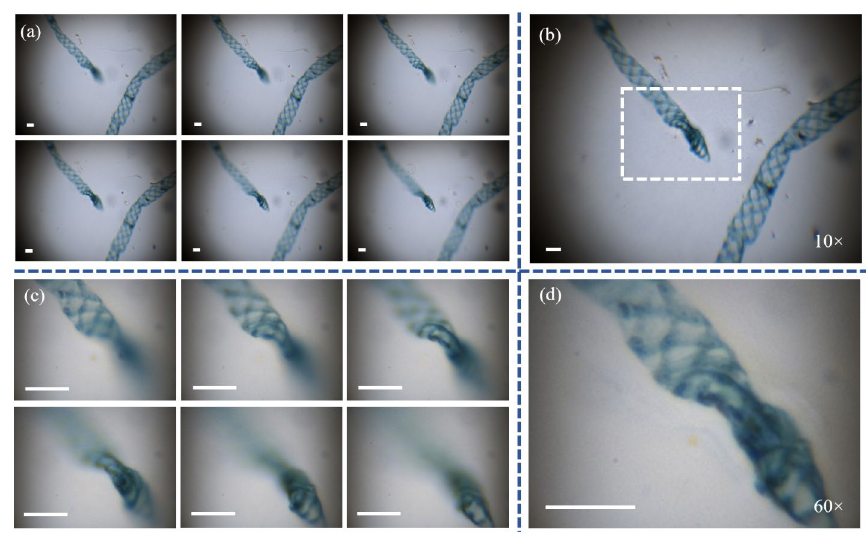
Fig. 10 Extended depth of field images of the sample “spirogyra communis”. (a) Image sequences of the “spirogyra communis” from the bottom to the top at the magnification of 10 × . (b)Result of the “spirogyra communis” image fusion at the magnification of 10 × . (c) Image sequences of the “spirogyra communis” from the bottom to the top at the magnification of 60 × . (d) Result of the “spirogyra communis” image fusion at the magnification of 60 × . The scale bars in these pictures are 20